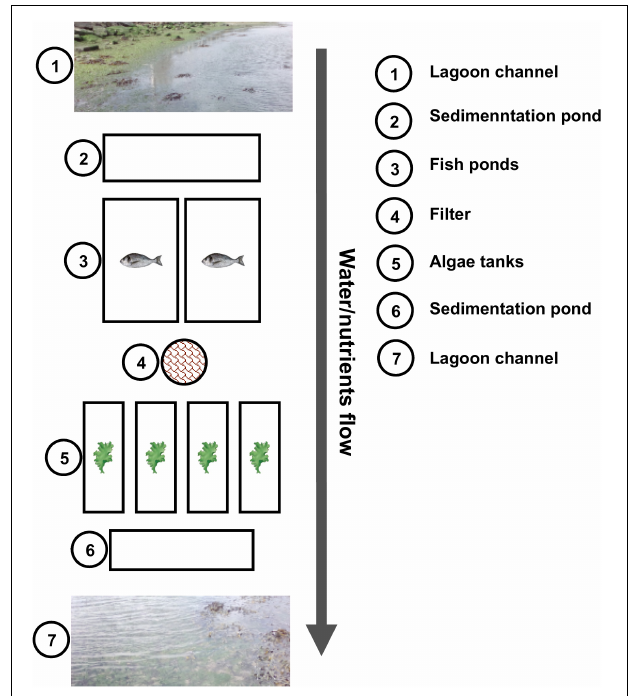
FIGURE 1 | Schematic representation of ALGAplus production site. The image was taken and modified with permission from Ghaderiardakani et al. (2019) under the terms of the Creative Commons Attribution License (CC-BY). The scheme does not show the total number of macroalgae tanks of the company